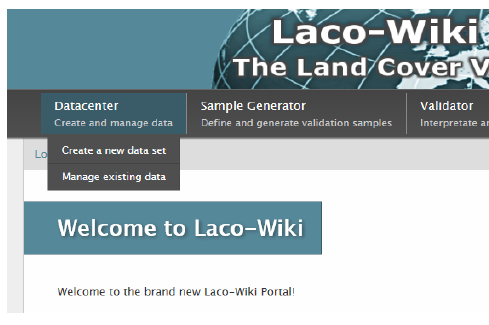
Figure 3. Starting the workflow from the Datacenter